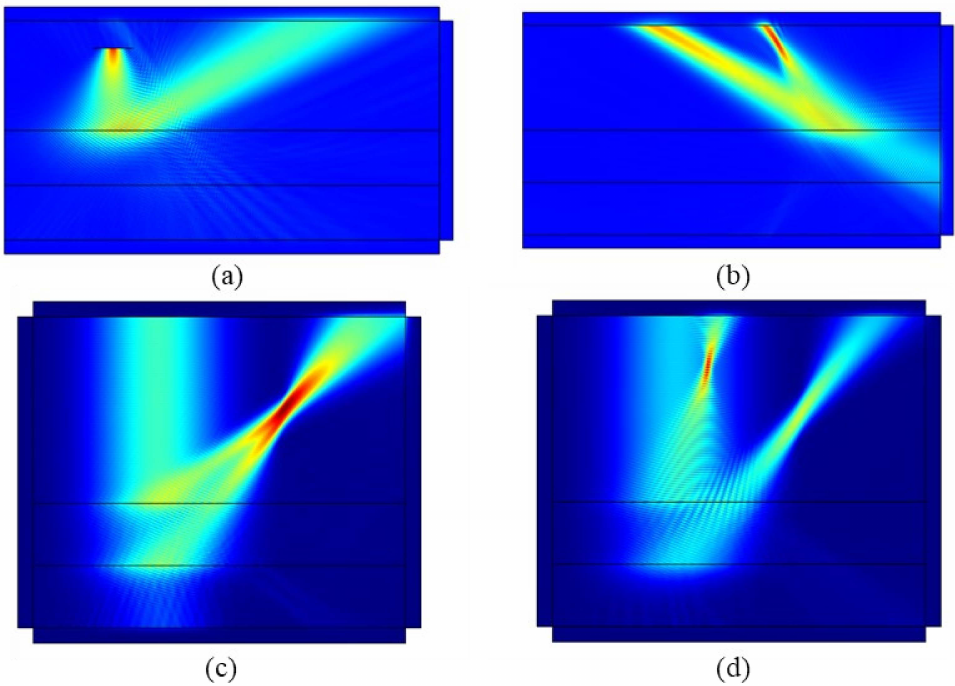
Figure 6. ( a ) Simulation diagram of in-coupling elements. ( b ) Simulation diagram of out-coupling elements. ( c ) Polarization multiplexing with one focus. ( d ) Polarization multiplexing with two